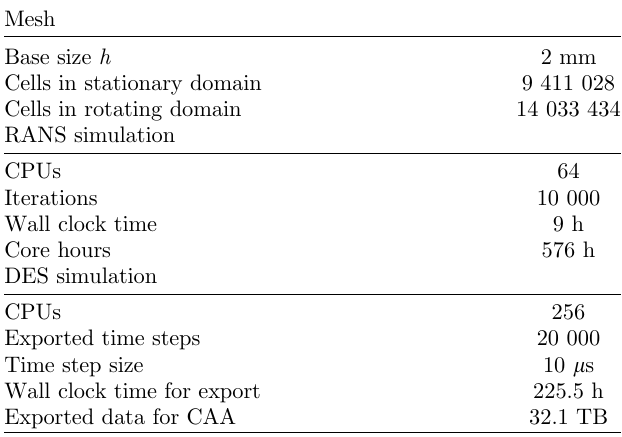
Table 3. CFD simulation statistics, including the computa- tional time of the simulation (Wall clock